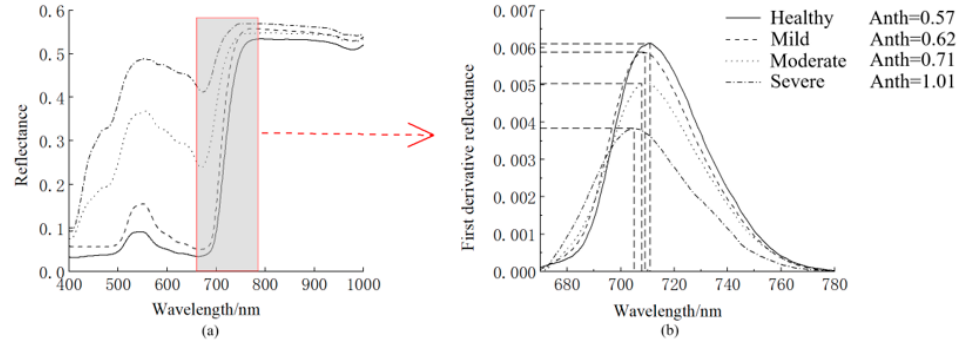
Figure 3. ( a ) Raw spectral features; ( b ) red edge of leaves with di ff erent